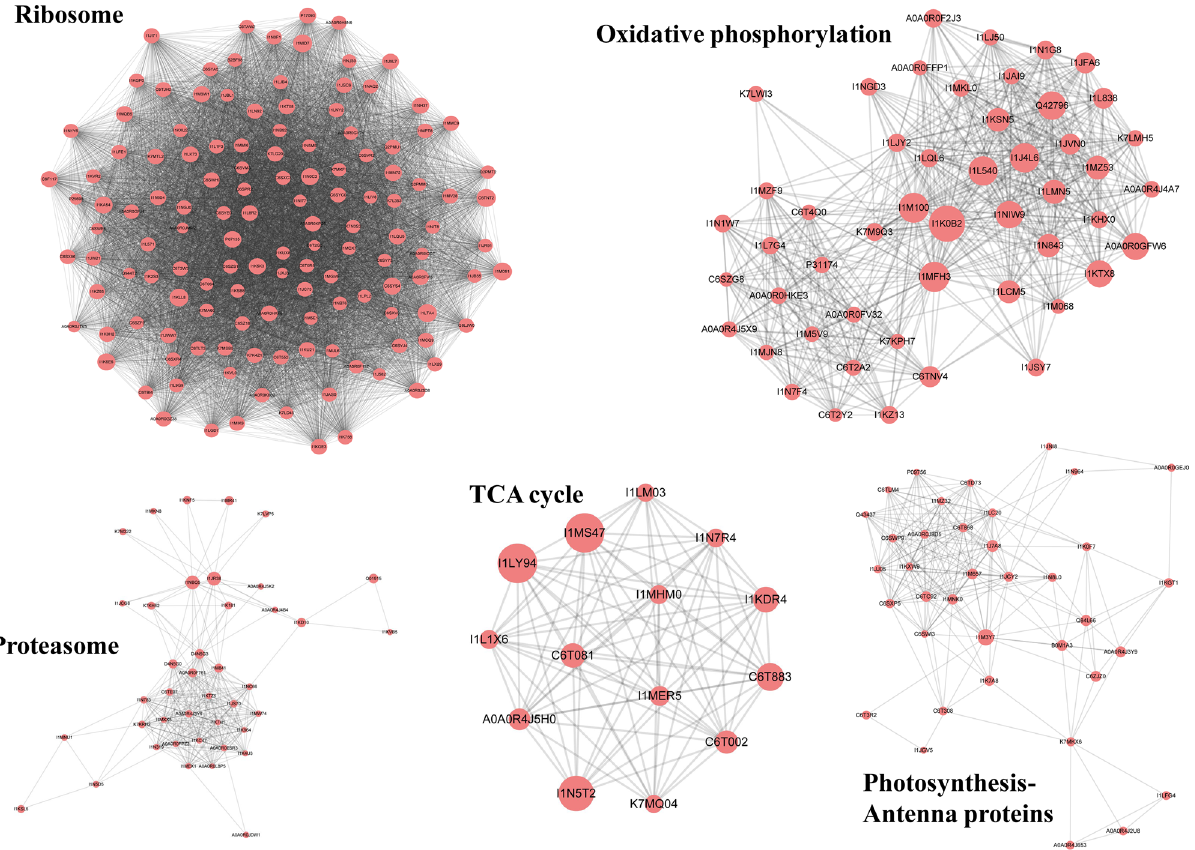
Figure 5. PPI network analysis of the Kac proteins. Five highly-connected clusters were